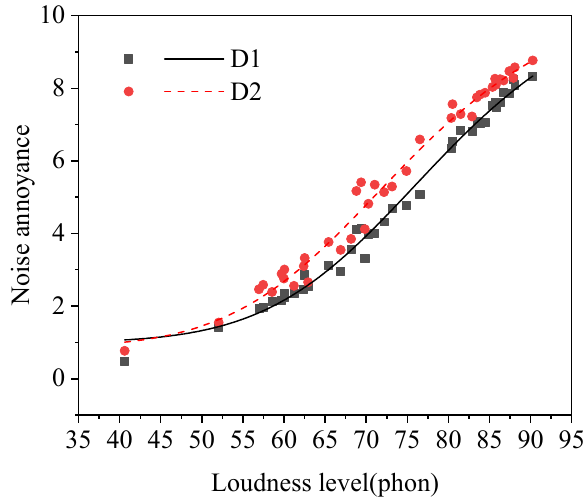
Figure 5. Noise annoyance of two groups of subjects with different noise sensitivities (subgroups D1–D2).